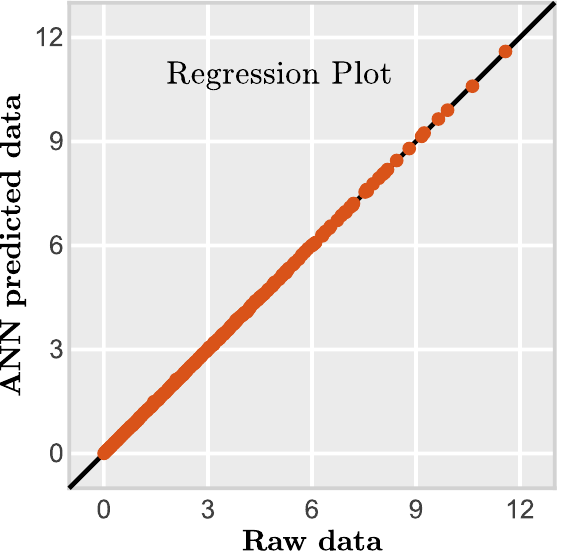
Figure 6. Training results for the ANN used for the laminar flame speed